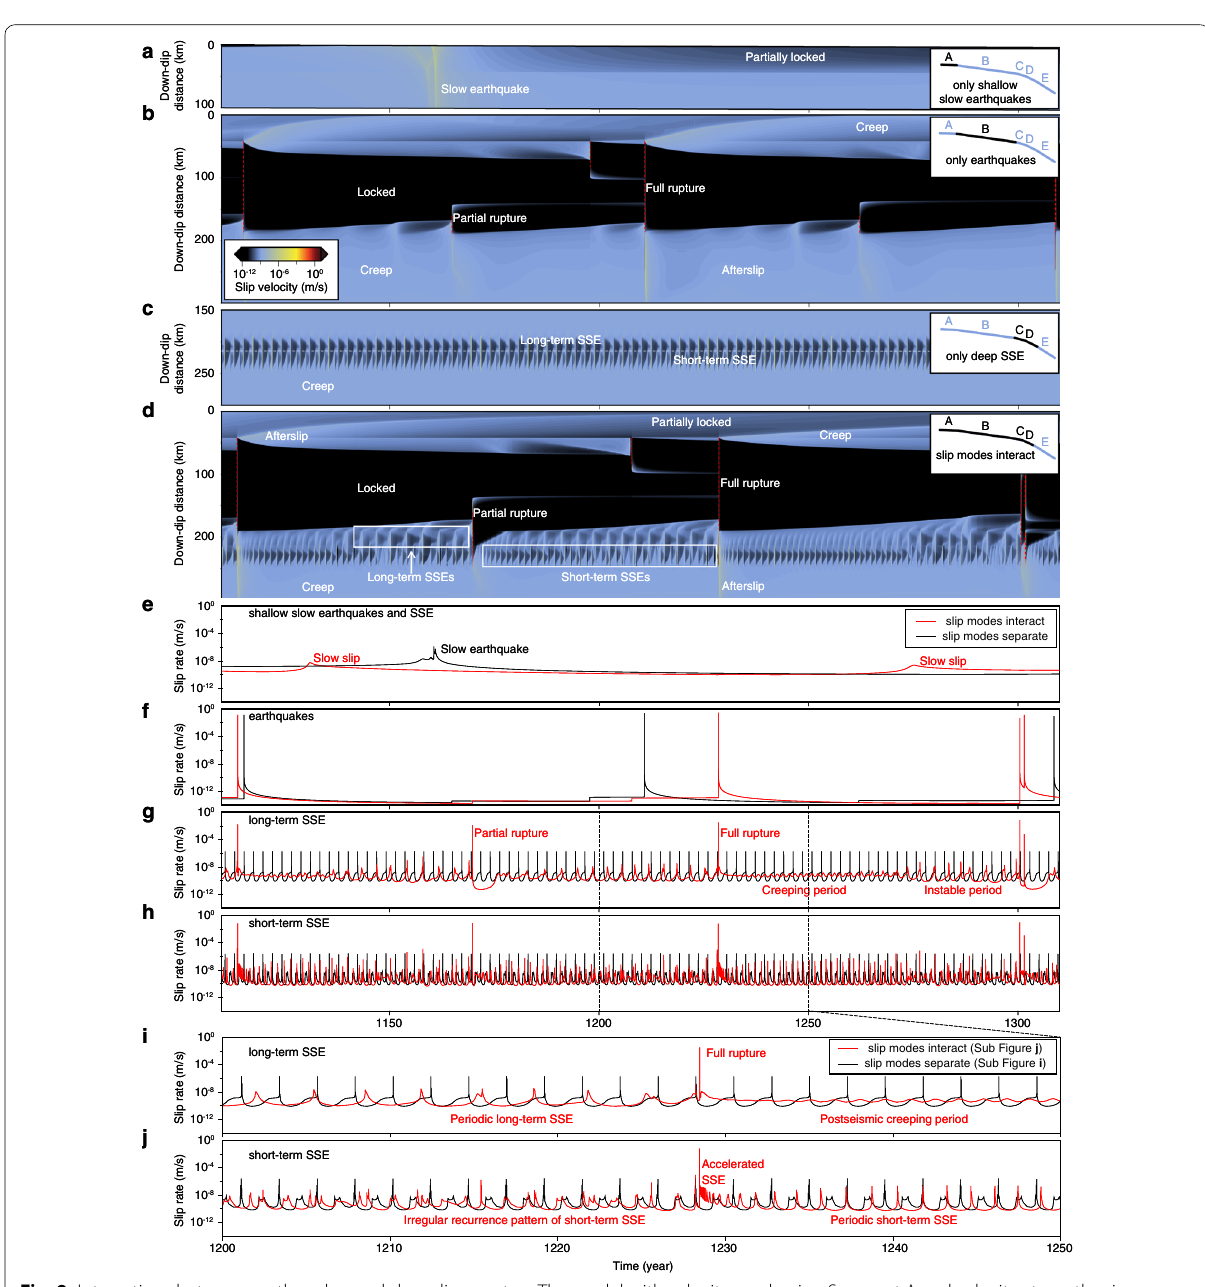
Fig. 9 Interactions between earthquakes and slow-slip events. a The model with velocity-weakening Segment A and velocity-strengthening down-dip segments produces slow-slip events every 490 years. b The model with a velocity-weakening seismogenic zone in the center and creeping neighboring segments produces periodic partial and full ruptures and afterslip propagating into the up-dip and down-dip segments. c The model with velocity-weakening segments C and D, surrounded by creeping zones, produces periodic long-term and short-term slow-slip events. d The reference 2D subduction model with velocity-weakening segments in accretionary prism, seismogenic zone, metamorphic shear zone and mantle lid shows highly variable seismic cycles. e Only long-recurrence-time slow earthquakes are produced in the model with only velocity-weakening segment A, while long-term slow slip appears in the coupled model. f The coupled model shows less regular full ruptures. g The long-term slow-slip events in the coupled model are suppressed at the beginning and facilitated in the later stage of the interseismic period. h The short-term slow-slip events in the coupled model are accelerated after the earthquakes and their recurrence time and amplitudes are irregular in the later stage of the earthquake cycle. i and j are enlarged view of the deep slow-slip events between 1200 and 1250 years, they are corresponding to g and h ,